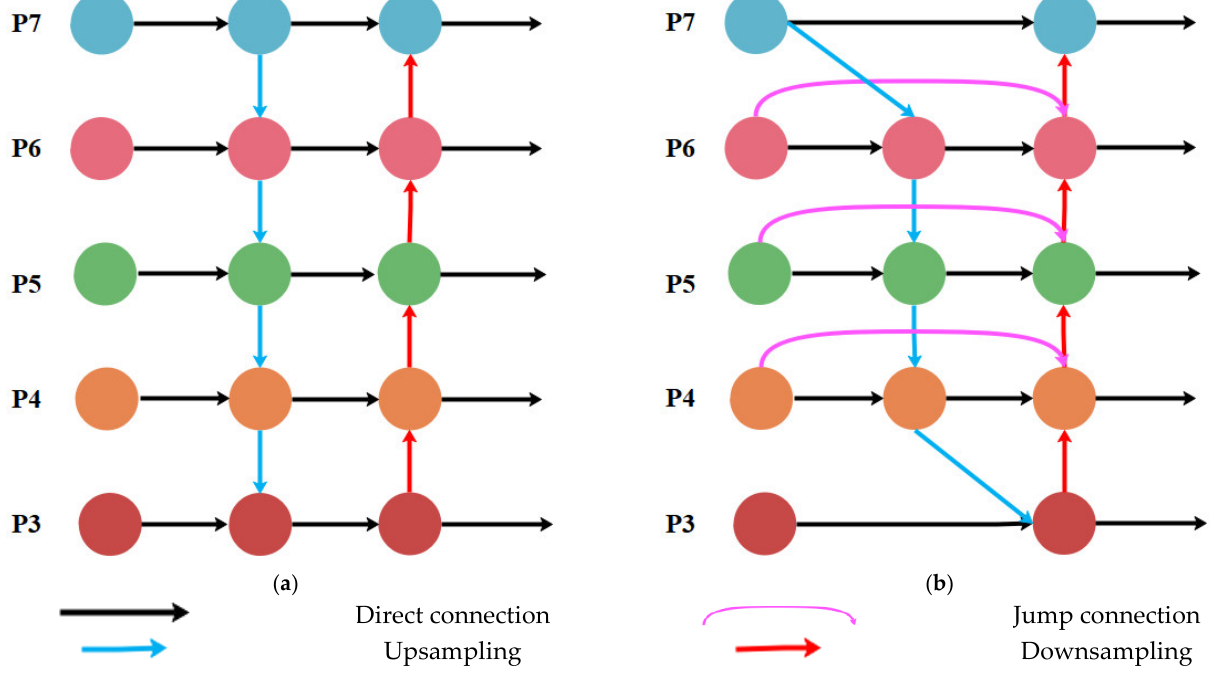
Figure 8. Bi-directional feature fusion network. ( a ) PANet with bi-directional feature fusion network, ( b ) BiFPN with bi-directional feature fusion network.